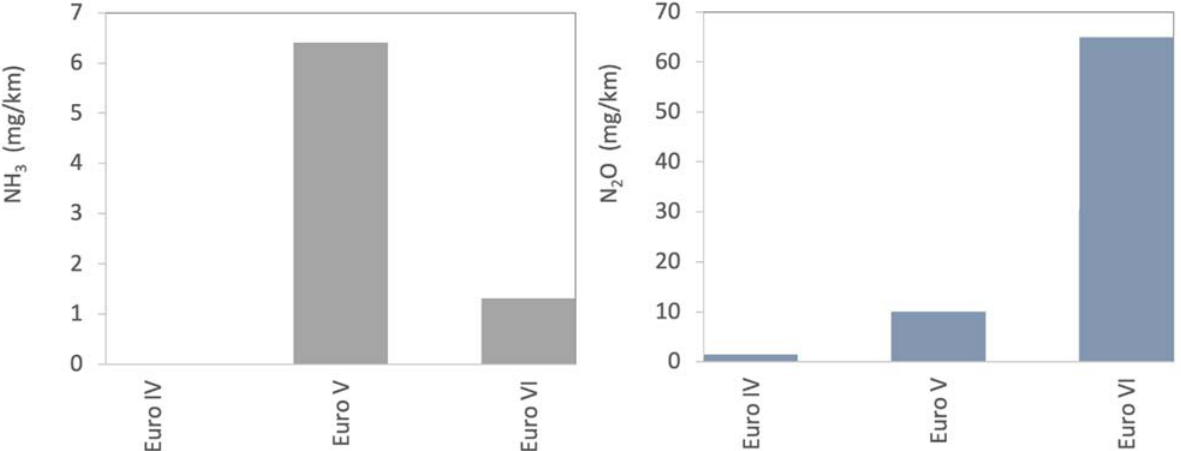
Figure 8. Emission factors of NH 3 ( left panel ) and N 2 O ( right panel ) from Diesel heavy ‐ duty vehicles.